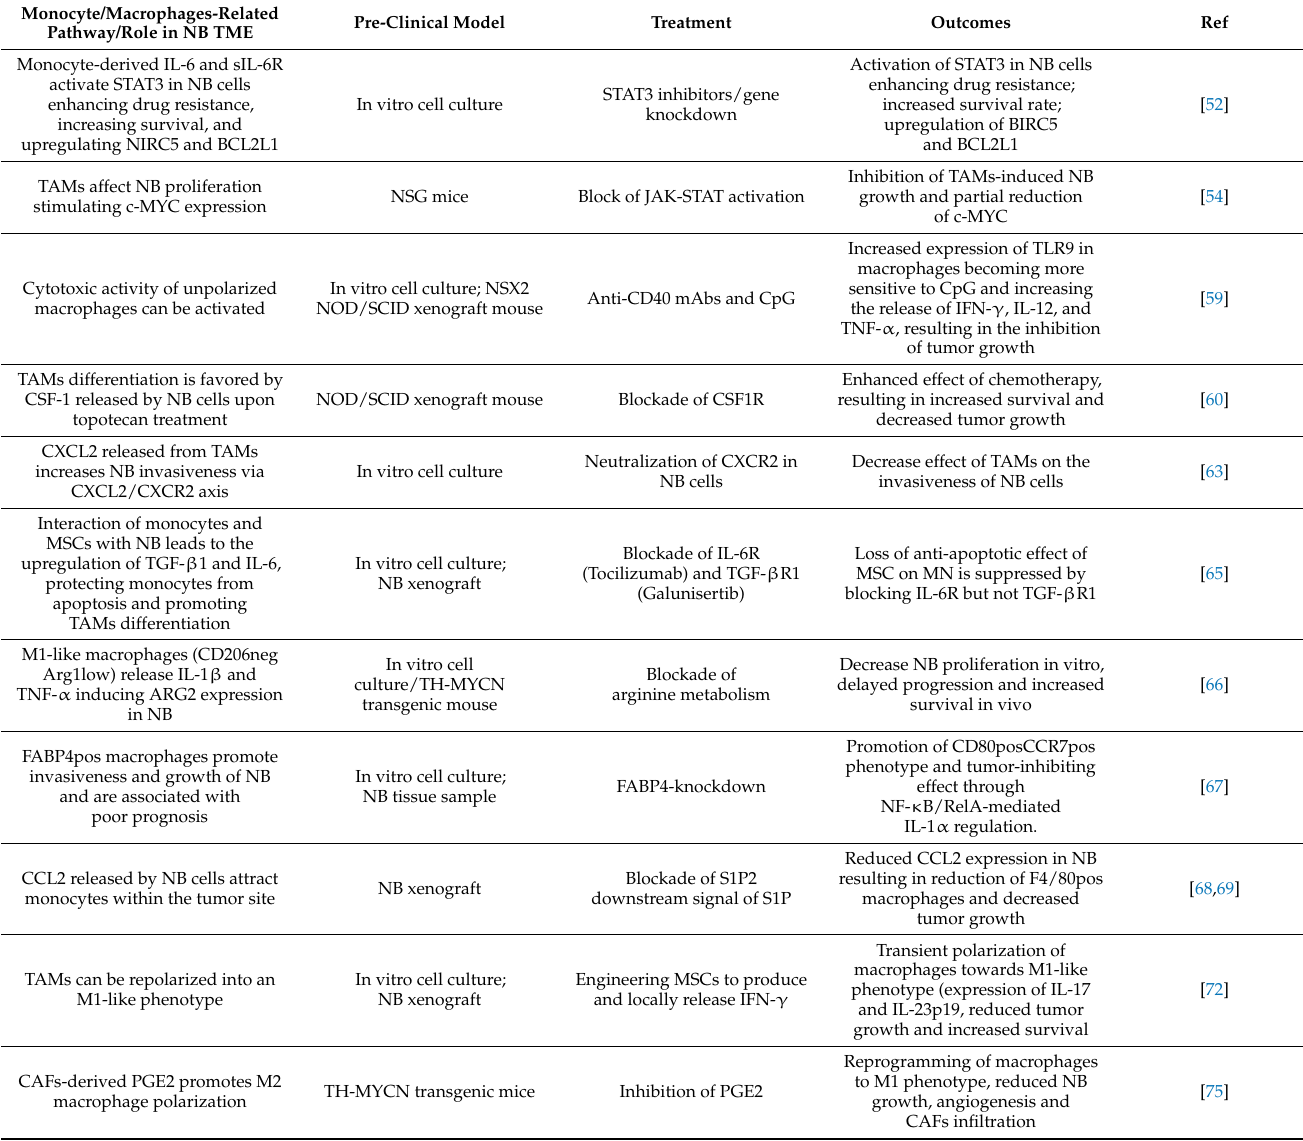
Table 1. Therapeutic strategy targeting monocyte/macrophages in NB TME in pre-clinical